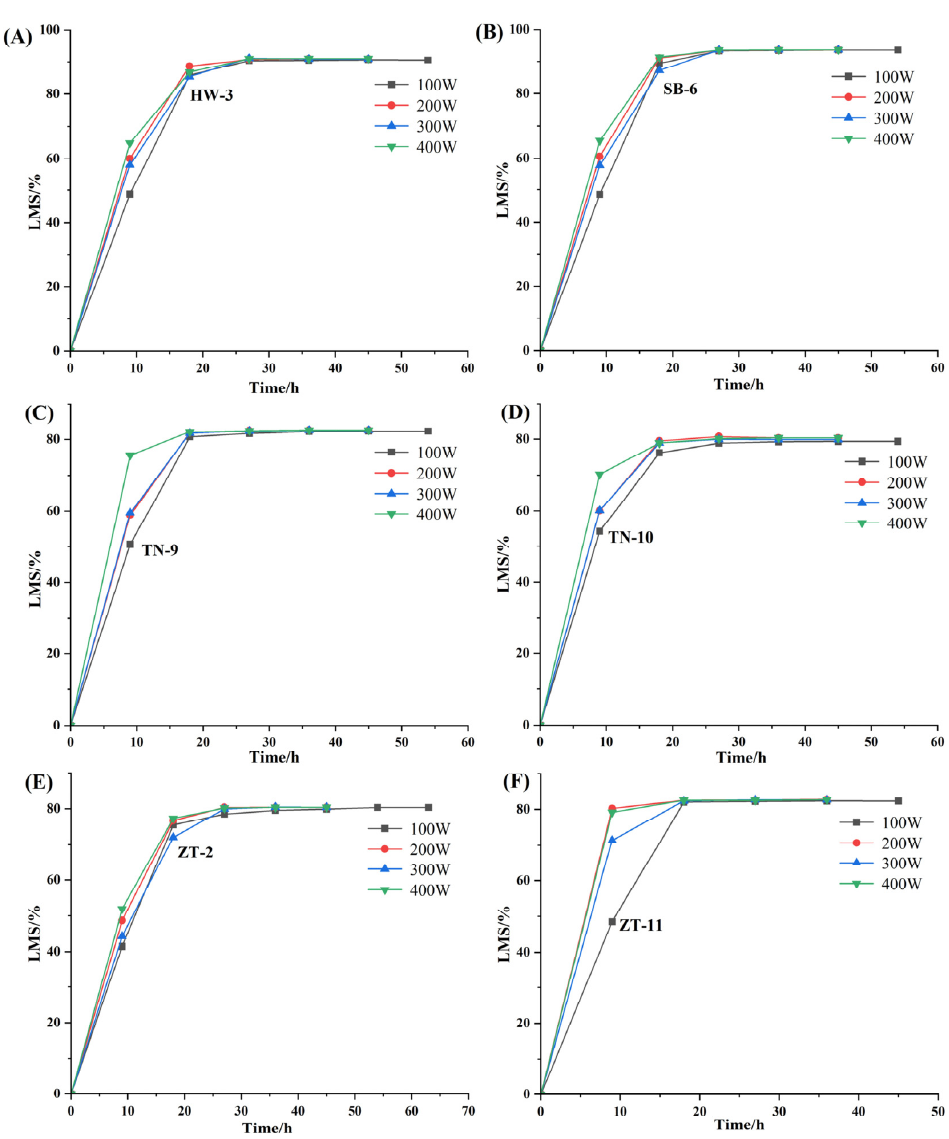
Figure 3. Relationship between ashing time and LMS of the coal samples by different powers using IoN 40 asher. ( A ) HW-3. ( B ) SB-6. ( C ) TN-9. ( D ) TN-10. ( E ) ZT-2. ( F ) Table 5. The LTAs yield (%) of coal samples obtained by the different programs of two ashers. Sample